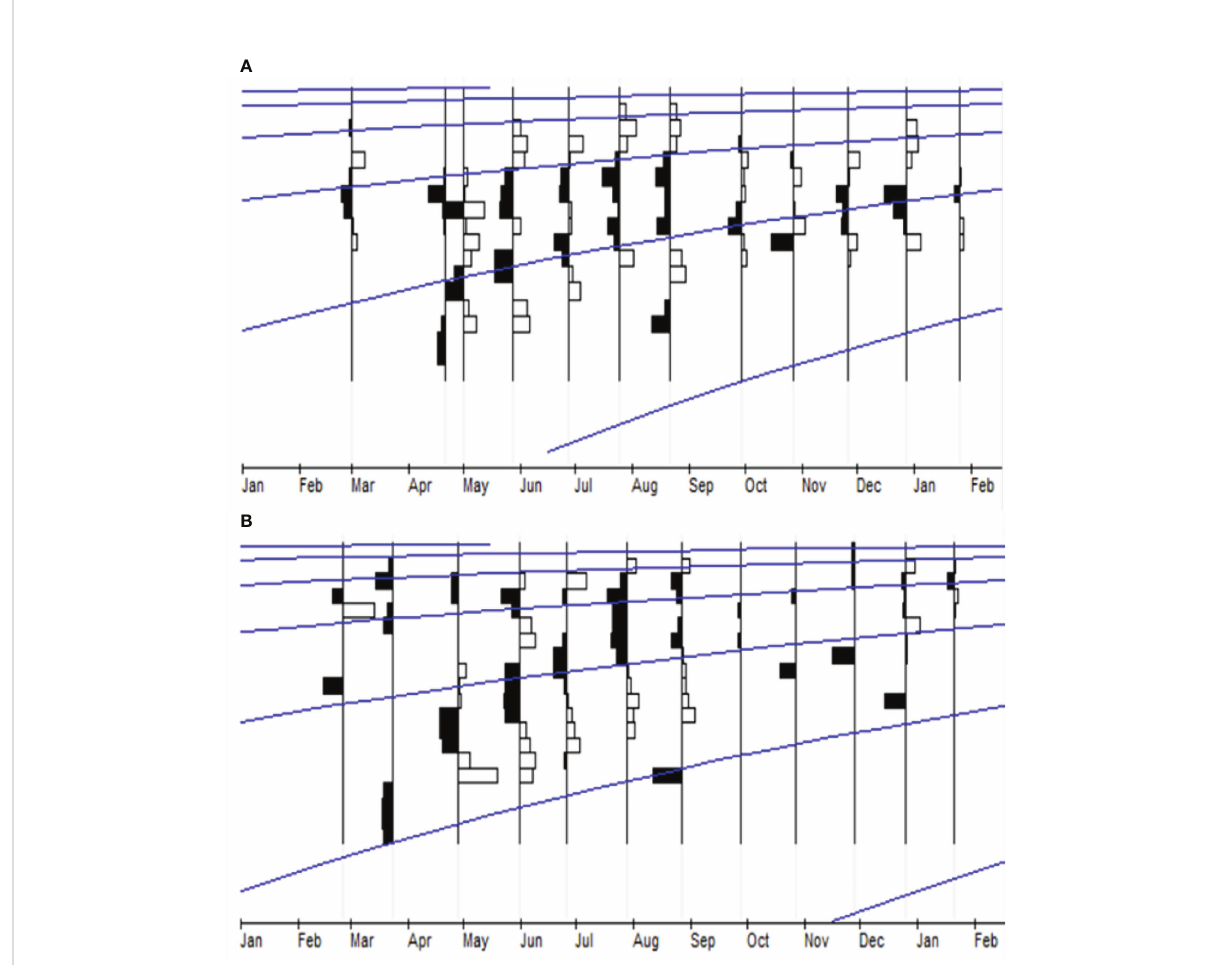
FIGURE 6 Length-frequency distribution data and the growth curves estimated using ELEFAN I module FISAT-II for (A) male and (B) female P. adspersus from the southeast Caspian Sea (2019 –